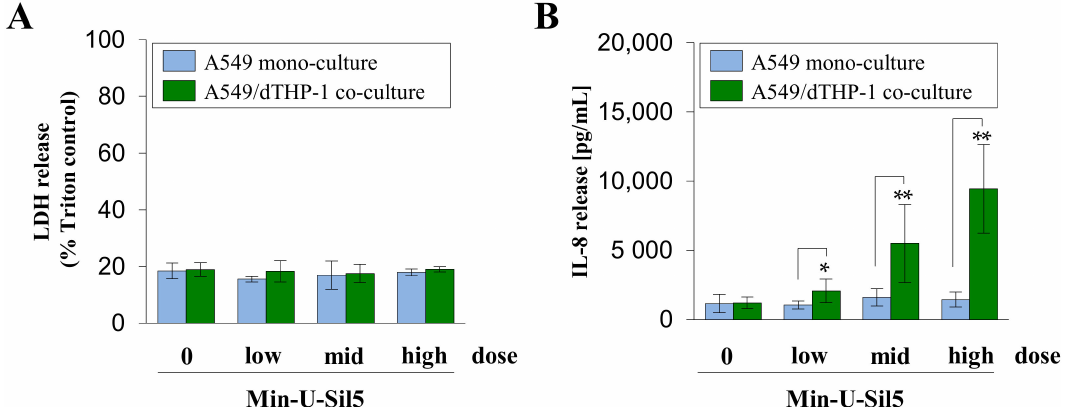
Figure 6. Assessment of cytotoxicity ( A ) and IL-8 release ( B ) from A549 mono- and A549/dTHP-1 co- cultures after air–liquid interface (ALI) exposure to Min-U-Sil5. A549 cells were seeded in trans-well inserts with a density of 2 × 10 5 /cm 2 , followed by dTHP-1 cells in a density of 3 × 10 4 /cm 2 after 4 h for co-culture treatment. Afterwards, the medium in the apical compartment was removed to establish ALI conditions and the cells were exposed to 15.8 ± 0.1, 29.1 ± 2.1 and 60.9 ± 2.1 µ g/cm 2 (mono-culture) or 16.4 ± 0.5, 31.0 ± 0.6 and 58.1 ± 3.9 µ g/cm 2 Min-U-Sil5 (co-culture) in the Vitrocell Cloud, followed by 24 h post-incubation. Supernatants were analyzed for LDH and IL-8 release. The means ± SD of three independent experiments performed in duplicates are displayed. Statistical analysis was performed to assess differences between the mono- and co-cultures using student’s t -test: * ( p ≤ 0.05), ** ( p ≤